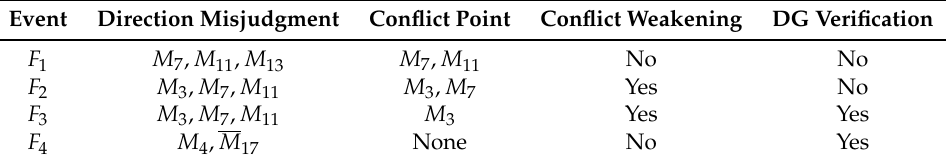
Table 2. Direction misjudgments and conflict points.